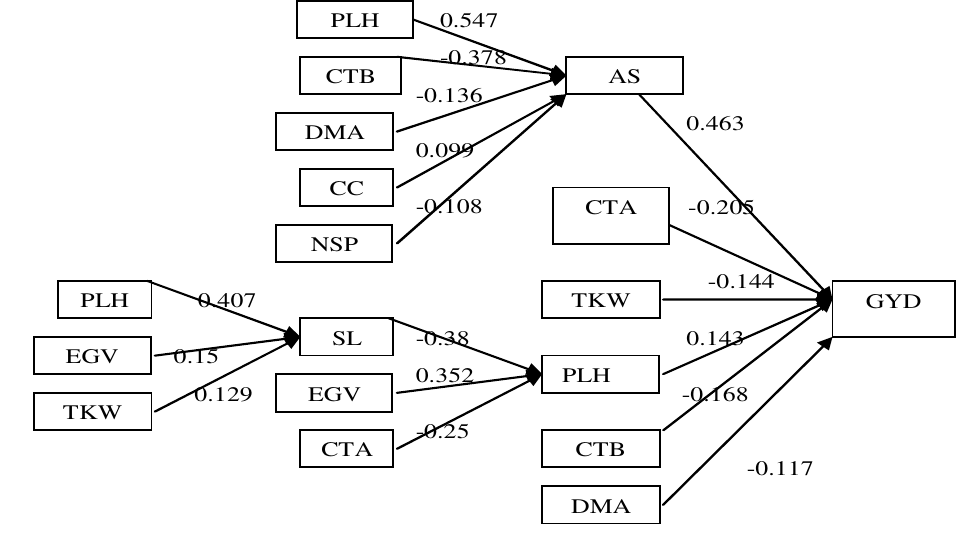
Fig. 1. Sequential path model indicating the interrelationships among grain yield whit related traits. GYD: grain yield; TKW: thousand kernel weight; DMA: days to physiological maturity; PLH: plant height; CC: chlorophyll content; SL: spike length; CTB: canopy temperature 10 day before anthesis; CTA: canopy temperature at anthesis; WAX: leaf waxy; EGV: early growth vigor; AS: agronomic score Tab. 2. Simple correlation coefficients (r) for the estimated eleven variables of wheat Traits